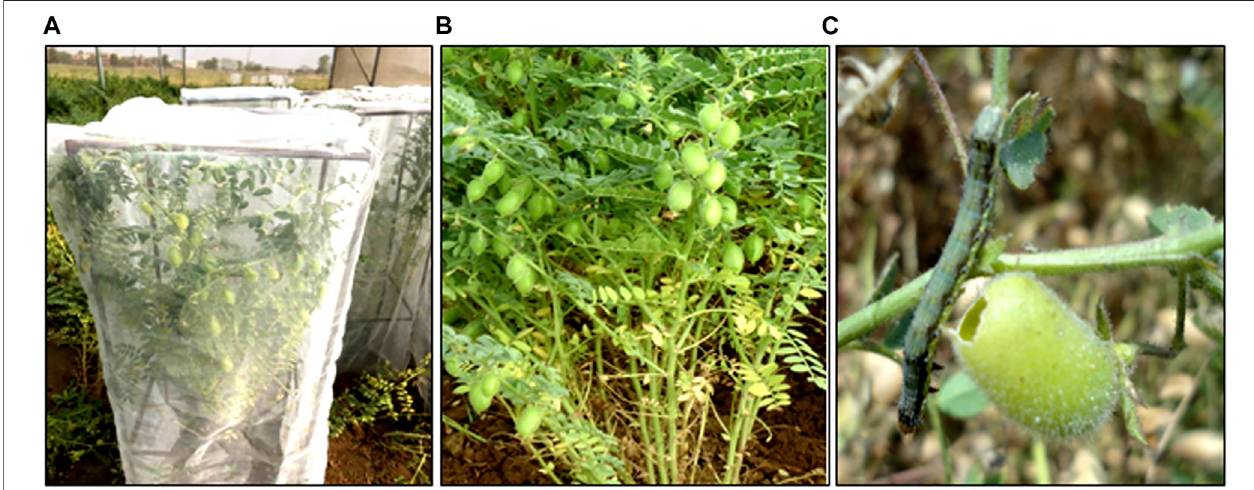
FIGURE 4 | Bioassay on BC 2 F 3 plants obtained from Cross C (PBG7 × BS 100E) expressing cry1Ac for toxicity to H . armigera through whole plant screening. (A) Caged plants displaying healthy leaves and pods. (B) Closer view of plant showing healthy leaves and pods. (C) Non-transgenic recipient parent PBG7 exhibiting damaged pod and surviving